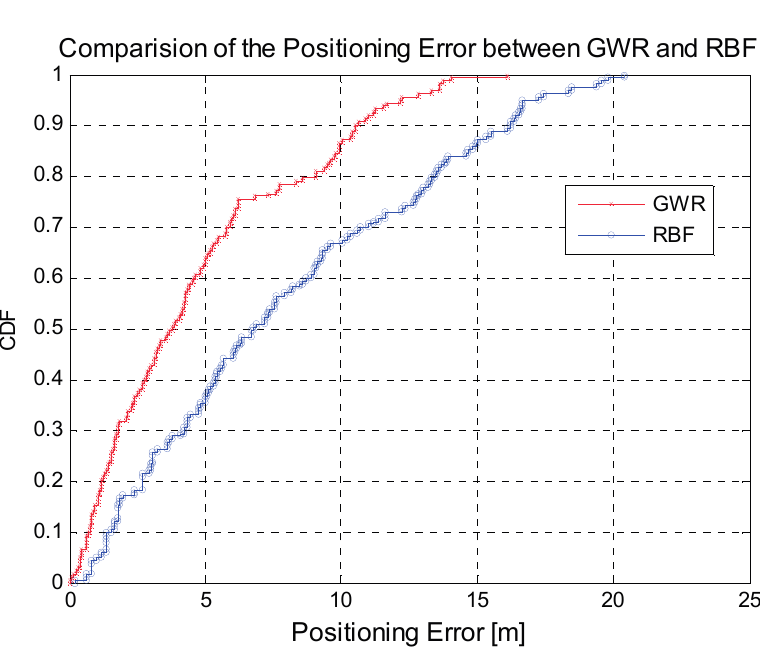
Figure 13. Positioning error based on GWR and RBF in scenario